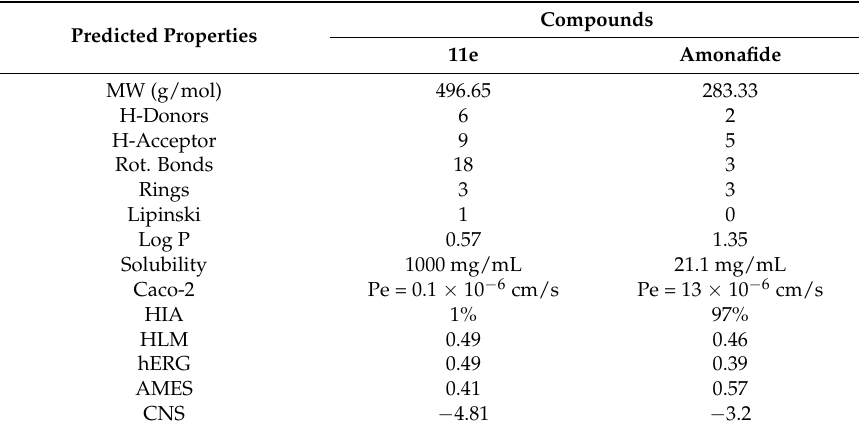
Table 4. Physico-chemistry properties and ADMET profile of compound 11e and amonafide calculated using the Program ACD/Percepta.